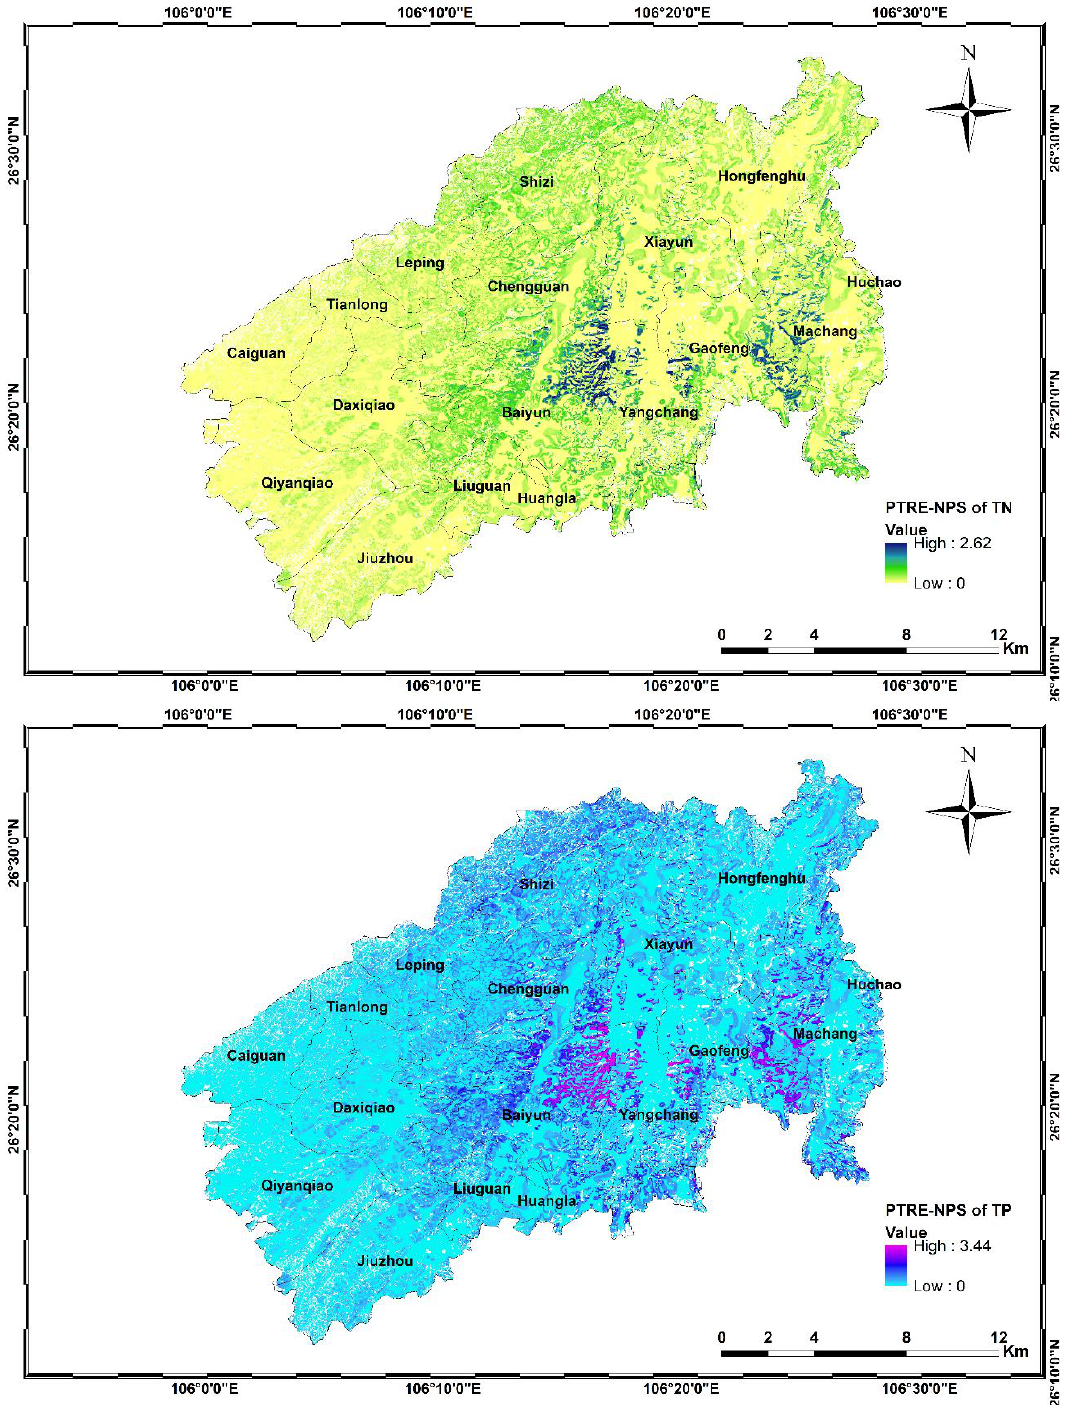
Figure 5. Spatial distribution of PTRE – NPS of TN and TP in the Hongfenghu reservoir watershed.